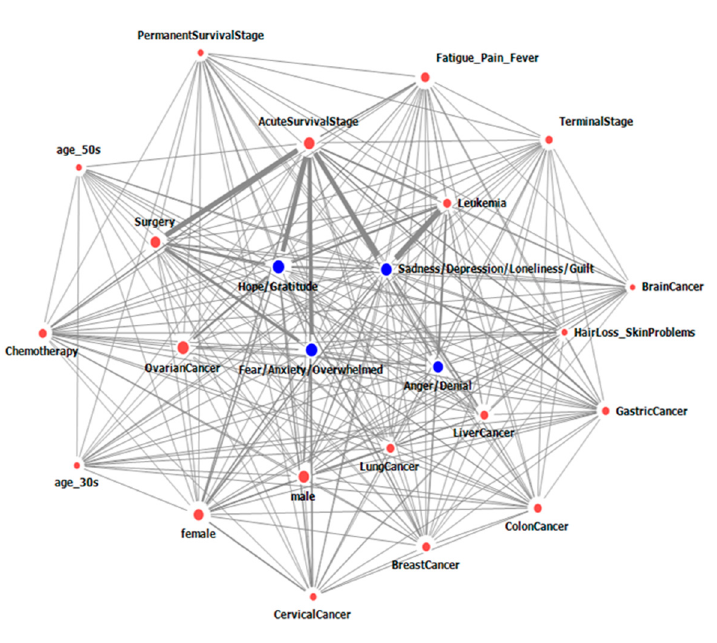
Figure 2. Network of emotion groups relating to cancer and factors affecting emotions groups, as determined through posts on Twitter.